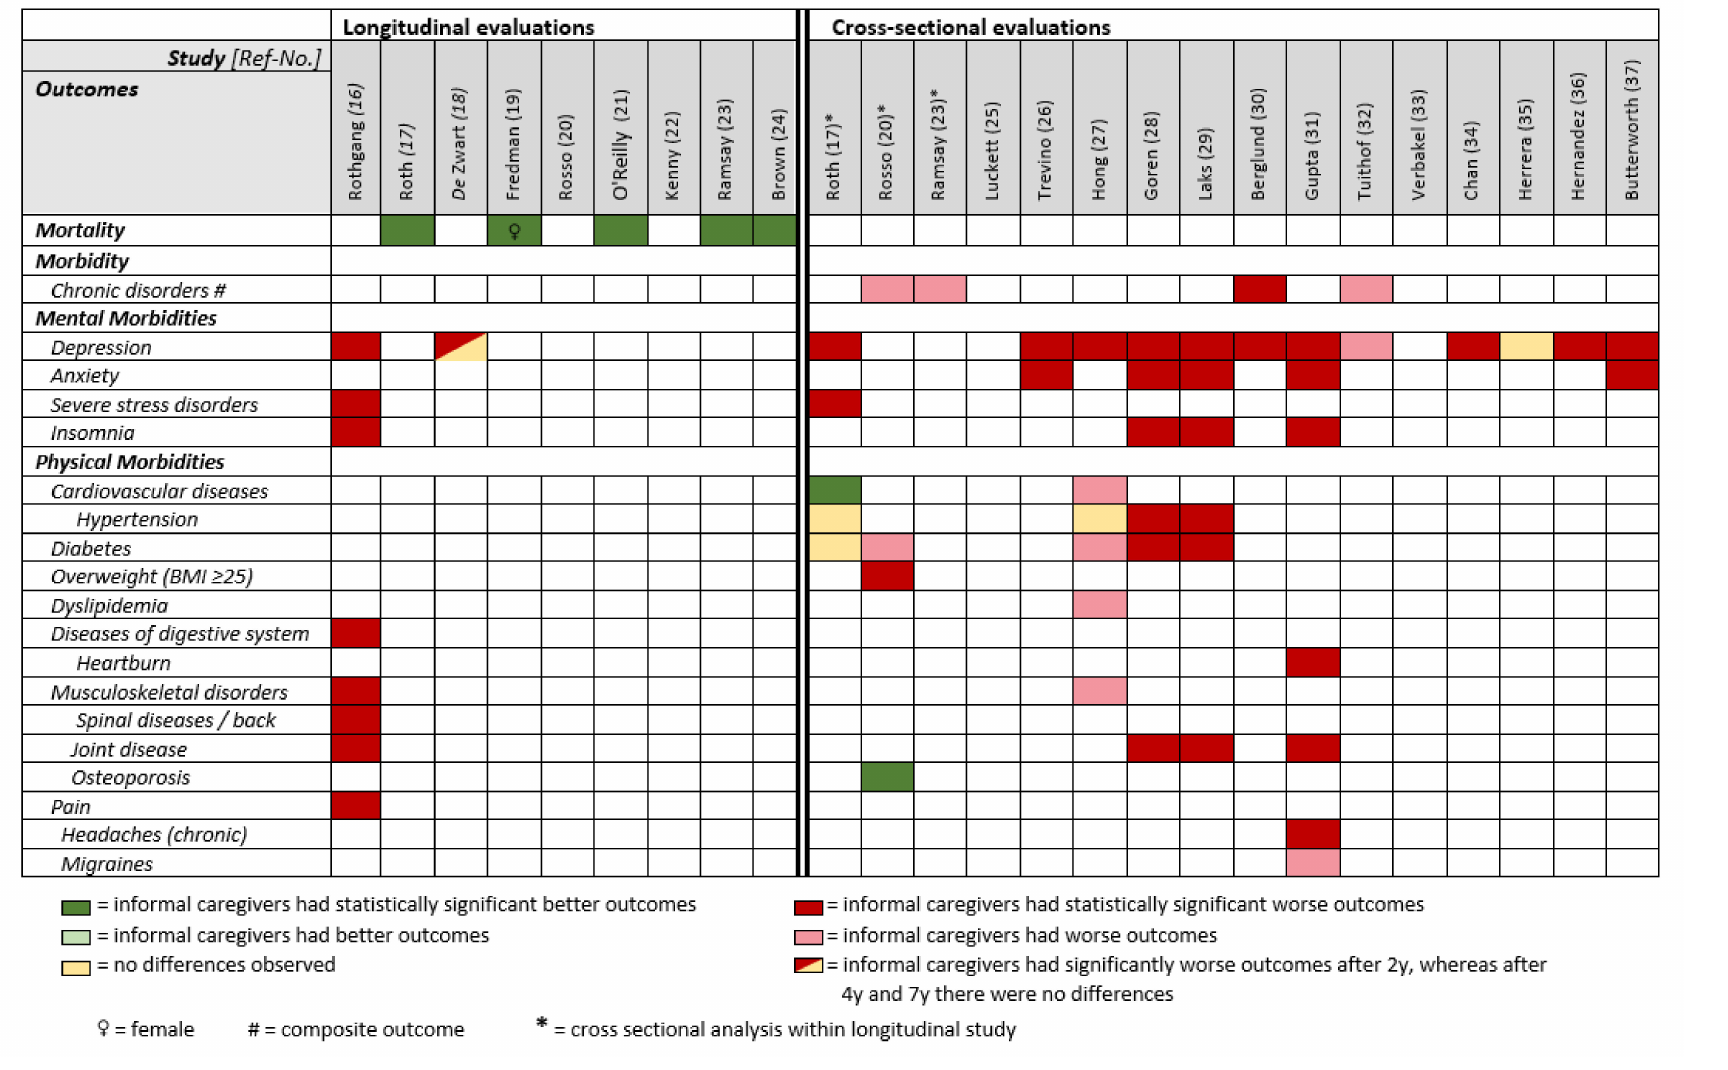
Figure 3. Simplified overview comparing mortality/morbidity outcomes between informal caregivers and non-caregivers in observational